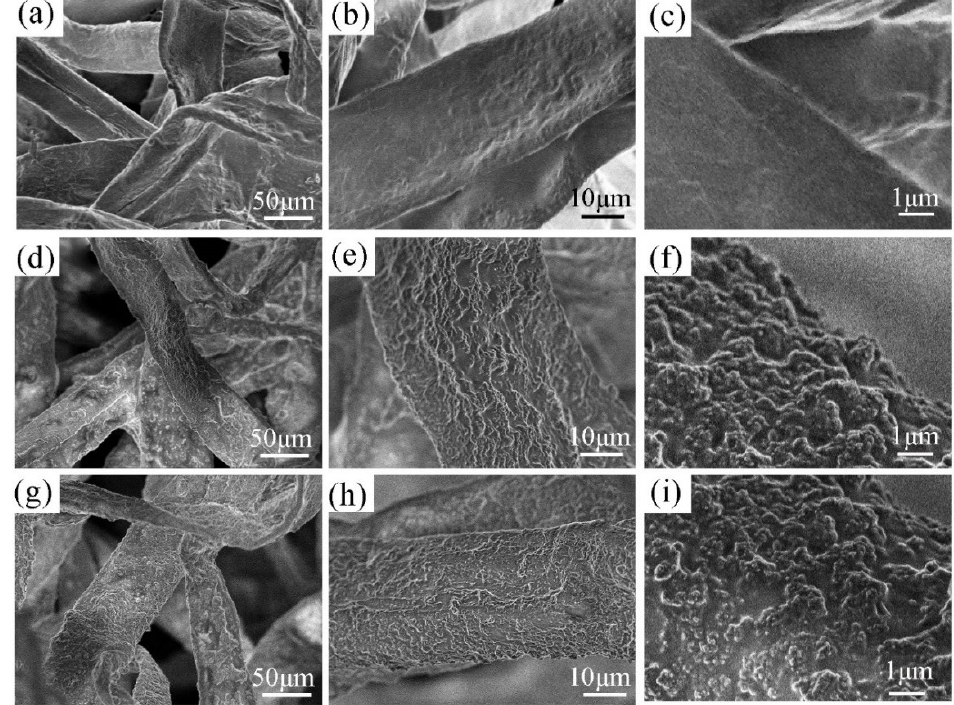
Figure 8. SEM images of the paper surface ( a – c ) Original paper; ( d – f ) Modified paper coated with PTSPM-PMETAC/SiO 2 -NH 2 solution; ( g – i ) Modified paper that has been soaked many times.